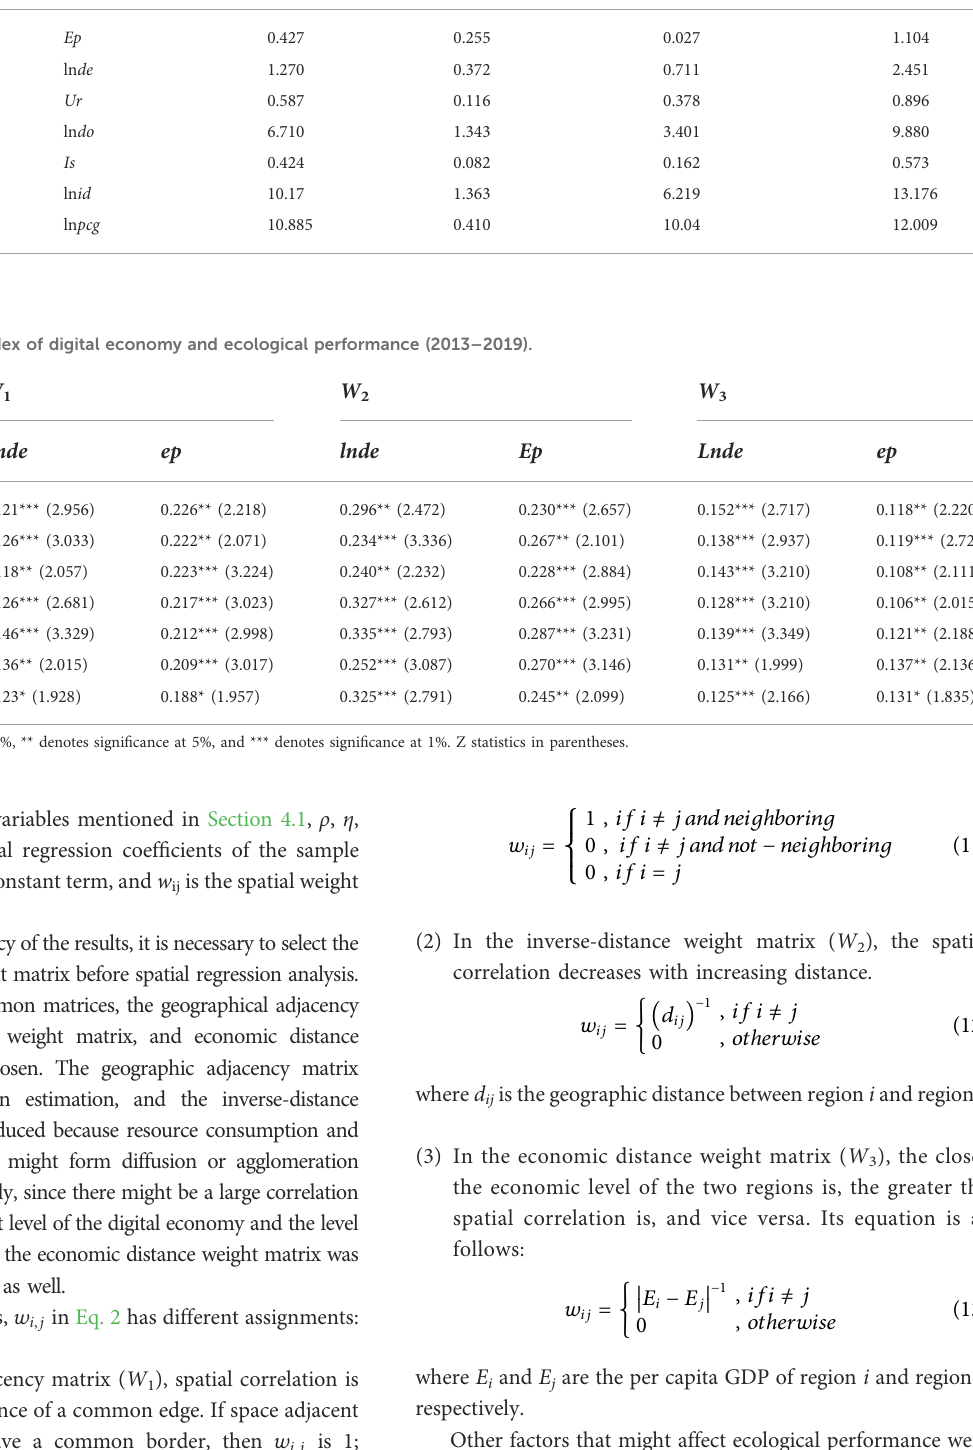
TABLE 4 Descriptive statistics of each variable. Variable type